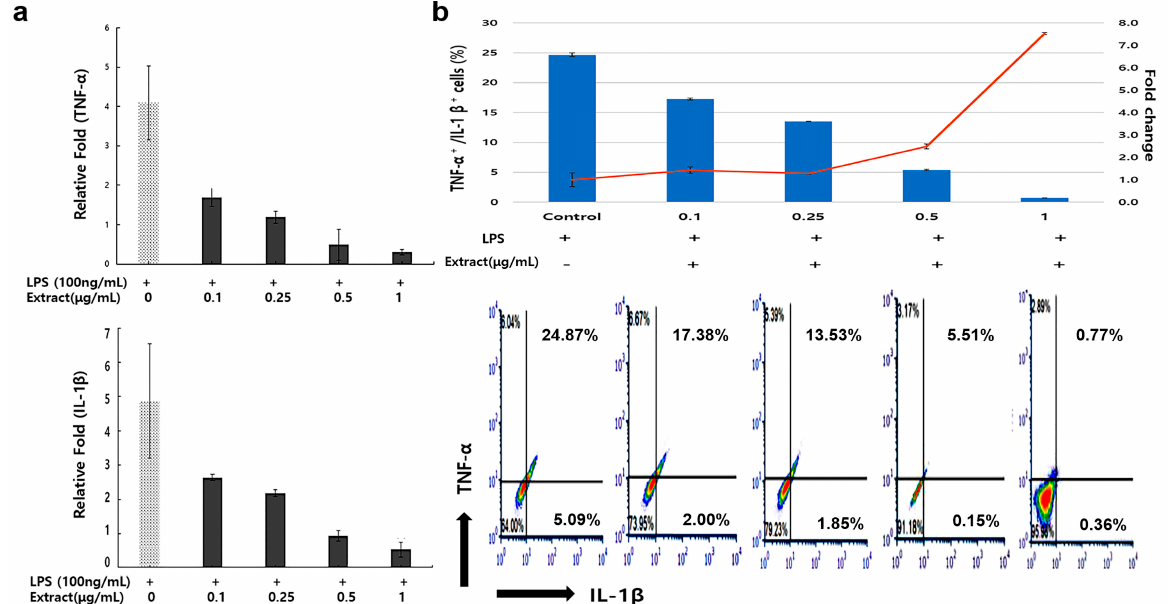
Figure 3. Expression levels of IL-1 β and TNF- α from macrophages activated by Cordyceps militaris extracts under lipopolysaccharides (LPS) stress. Expression levels of IL-1 β and TNF- α from macrophages using qPCR and FACSCalibur have been shown in the ( a , b ) panels, respectively. The bar graphs shown in the ( b ) panel are the relative fold changes of double-positive cells by the doses of the extract under LPS stress. ( p < 0.05).